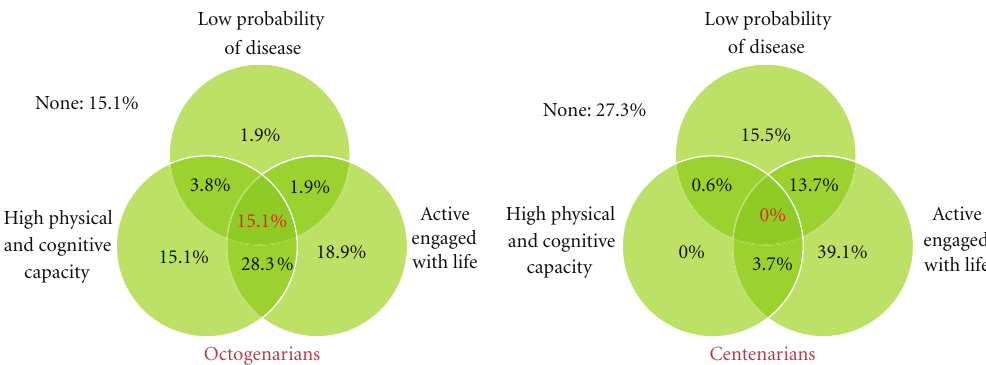
Figure 1: Drawings of age group comparisons for original successful aging model between octogenarians and centenarians. Numbers represent the proportion of each age group satisfied with components of the successful aging model.